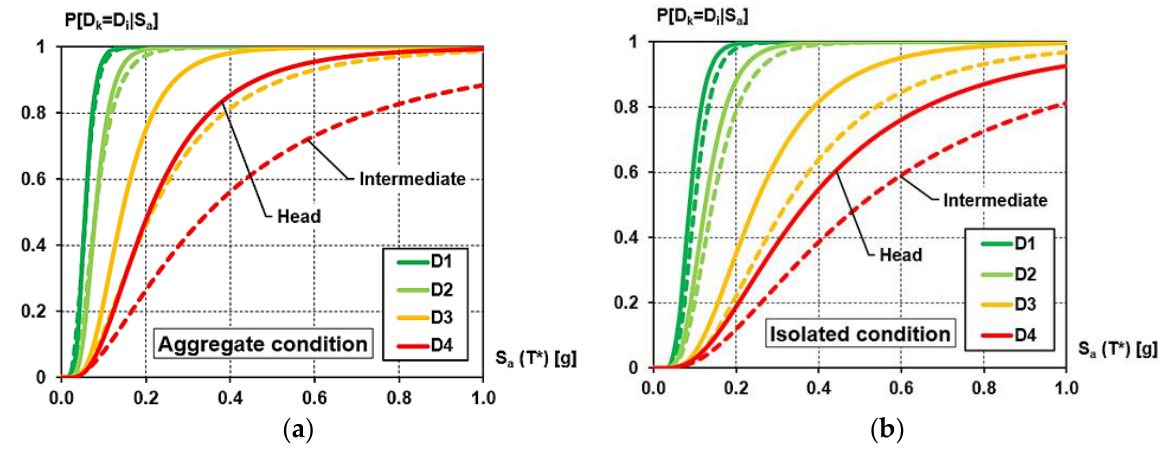
Figure 15. Comparison of fragility curves between intermediate and head S.Us in aggregate condition ( a ) and isolated one ( b ).